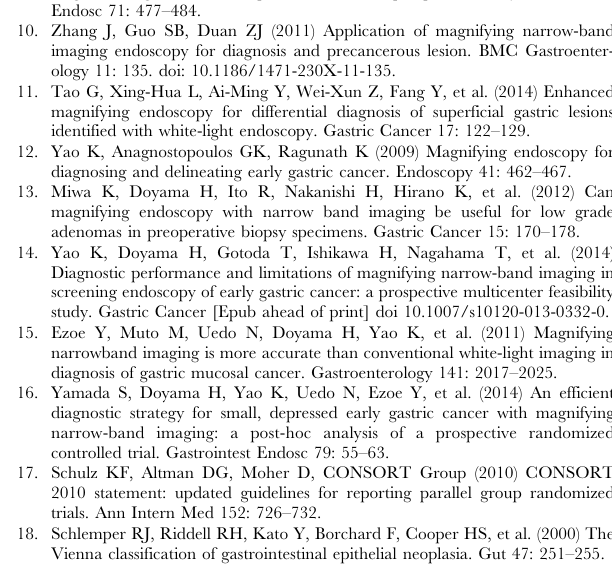
Table S6 Correspond to Table 5. Table S7 Correspond to Table 6. Table S8 Correspond to Table 7. Checklist S1 CONSORT